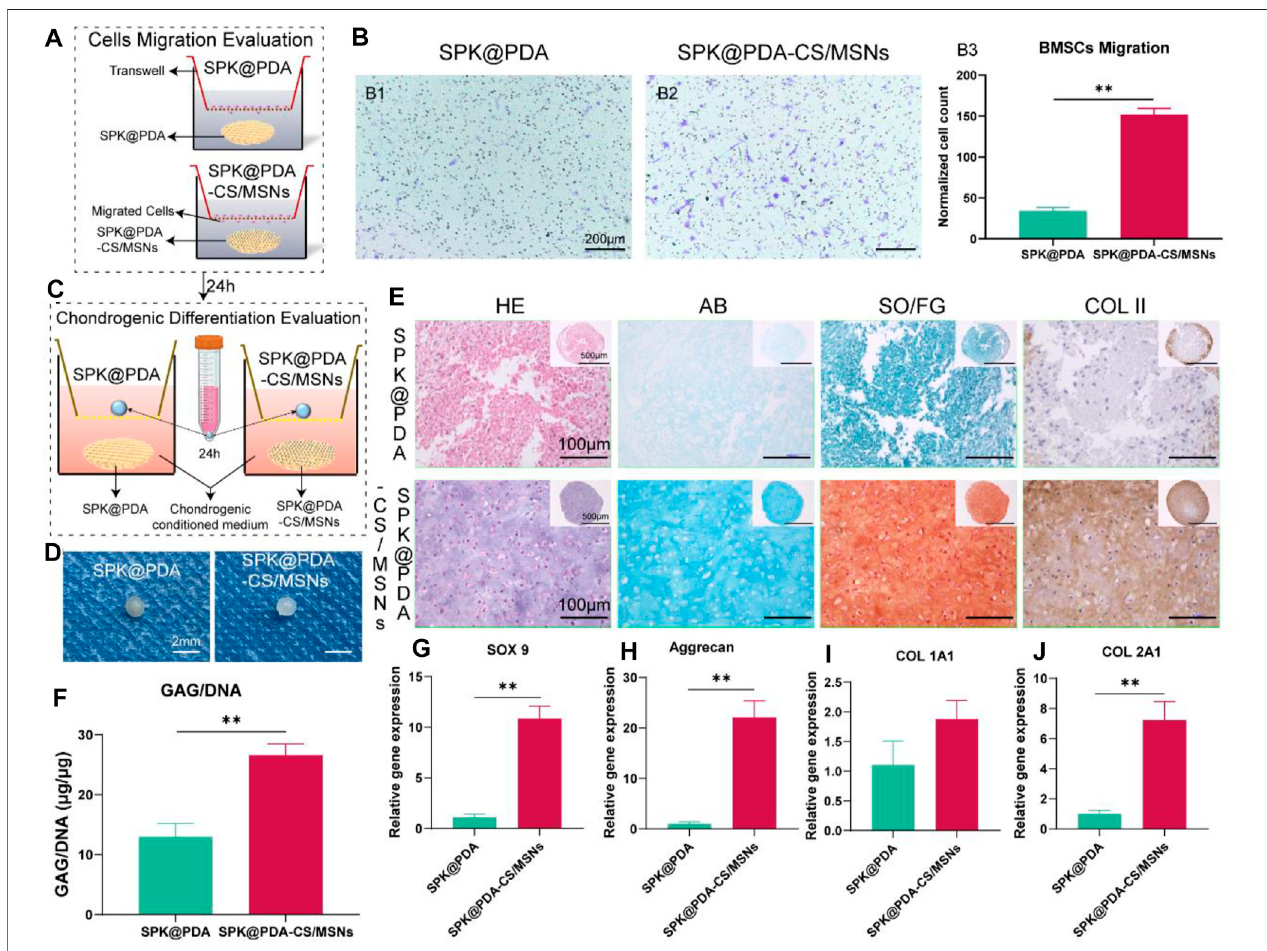
FIGURE5| Invitro cellmigrationandchondrogenicdifferentiationevaluationoftheSPK@PDAandSPK@PDA-CS/MSNsscaffolds. (A) Schematicillustrationofthe transwell cell migration model. (B) Cell migration assay of the scaffolds showed the representative images of migrated cells in the SPK@PDA (B1) and SPK@PDA-CS/ MSNs(B2)groups,andthequantitativeevaluationofmigratedcellsindifferentgroups(B3).Dataareshownasmean±SD, n =4.** p < .01. (C) Thetranswellsystemwas used to evaluate the chondrogenic differentiation effect of the SPK@PDA and SPK@PDA-CS/MSNs scaffolds. (D) Gross observation of the pellets treated with SPK@PDAandSPK@PDA-CS/MSNsscaffolds. (E) Histologicanalysisofthepellets. (F) GAGnormalizedbyDNAofthepellets.Dataareexpressedasmean±SD( n =3; ** p < .01).G-J.Expressionofcartilage-relatedgenesSOX9 (G) ,aggrecan (H) ,collagenI (I) ,andcollagenII (J) ofthepelletsthroughRT-PCR.Dataareshownasmean± SD, n = 3. ** p <